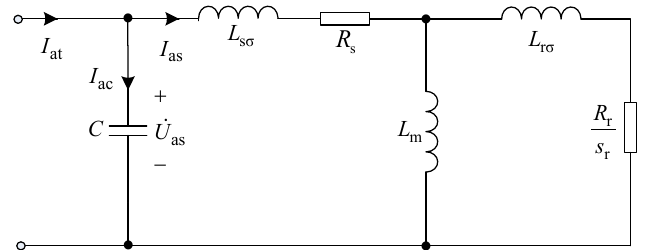
Figure 4. T − type equivalent circuit of IM with filter capacitor. Figure 4. T-type equivalent circuit of IM with filter capacitor.